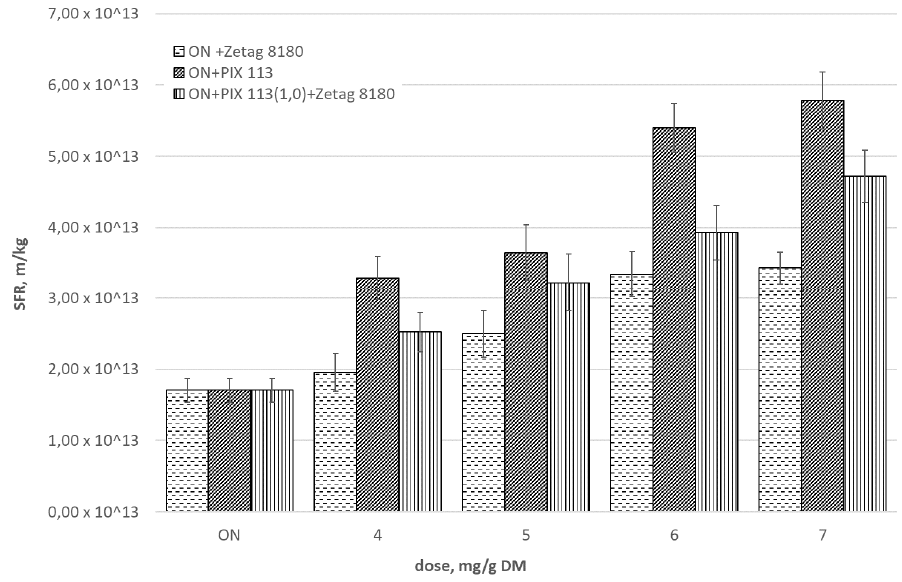
Figure 3. Effect of the dose of selected chemicals on SFR of sonicated sludge (A 1 = 15.25 µm).